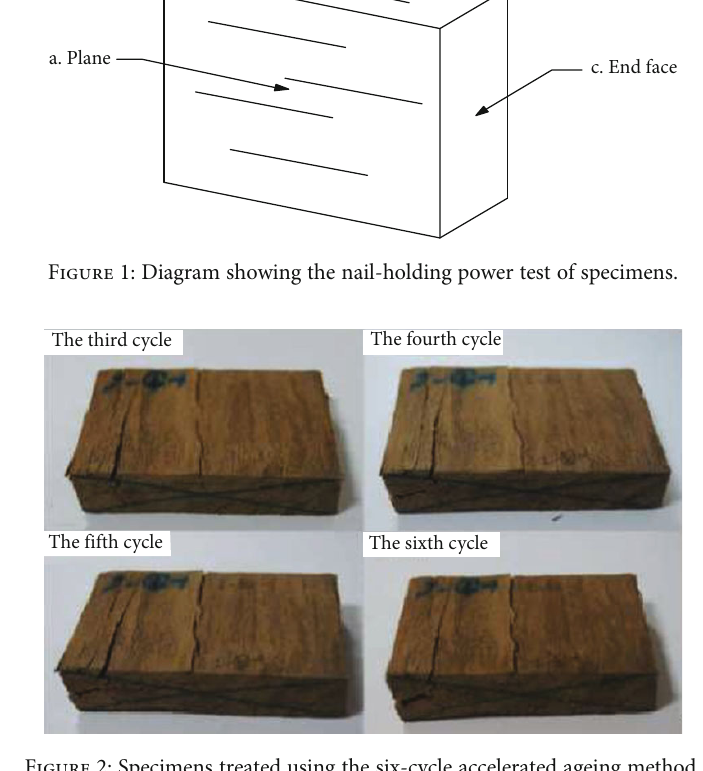
Figure 2: Specimens treated using the six-cycle accelerated ageing method.